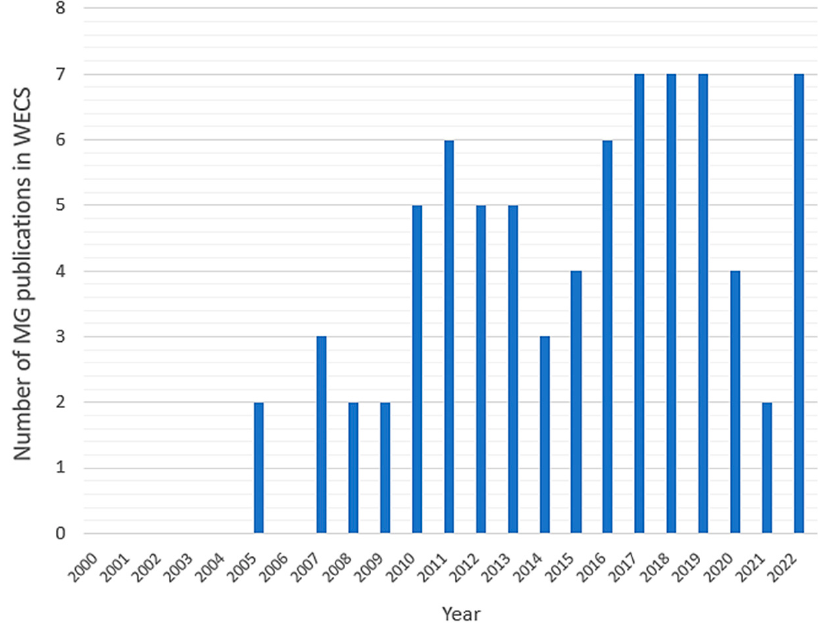
Figure 17. Publications of MGs applications in WECSs.